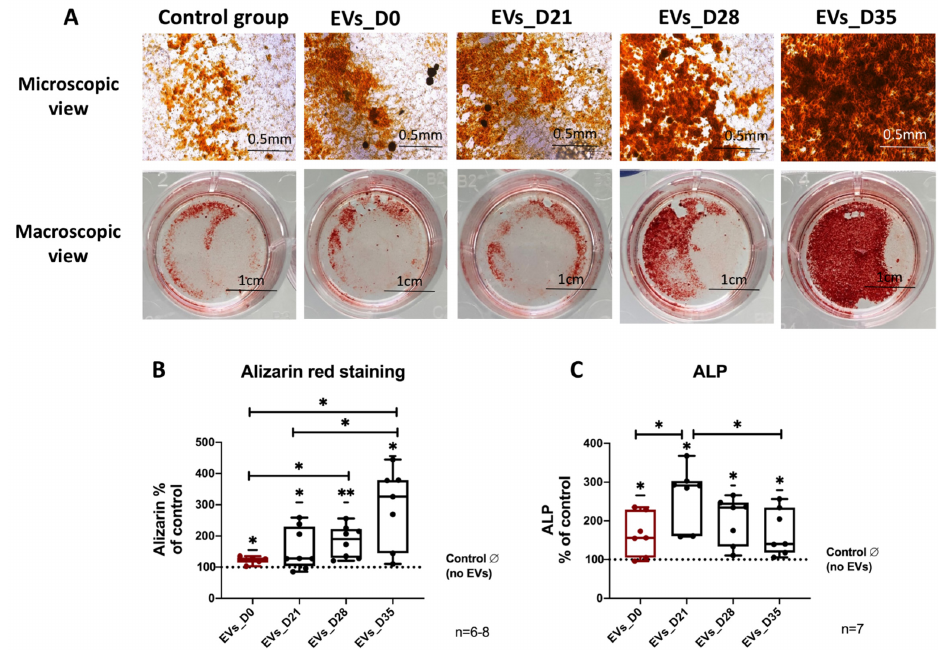
Figure 4. Evaluation of osteogenic differentiation of naïve hBMSCs after EV treatment. ( A ) Aliz- arin Red staining of hBMSCs after 21 days of osteogenic differentiation and treatment with the dif- ferent EVs groups. Microscopic view (scale bar: 0.5 mm) and macroscopic view (scale bar: 1 cm); n = 6–8. ( B ) Quantification of Alizarin Red staining; n = 6–8. ( C ) Alkaline Phosphatase (ALP) activity of hBMSC after 14 days of osteogenic differentiation and treatment with the different EV groups; n